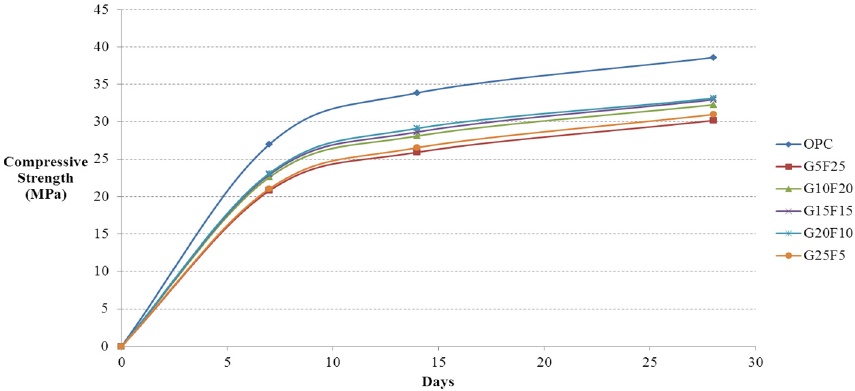
Figure 3. Compressive strength history of concrete with GGBS and flyash (W/B 45%).